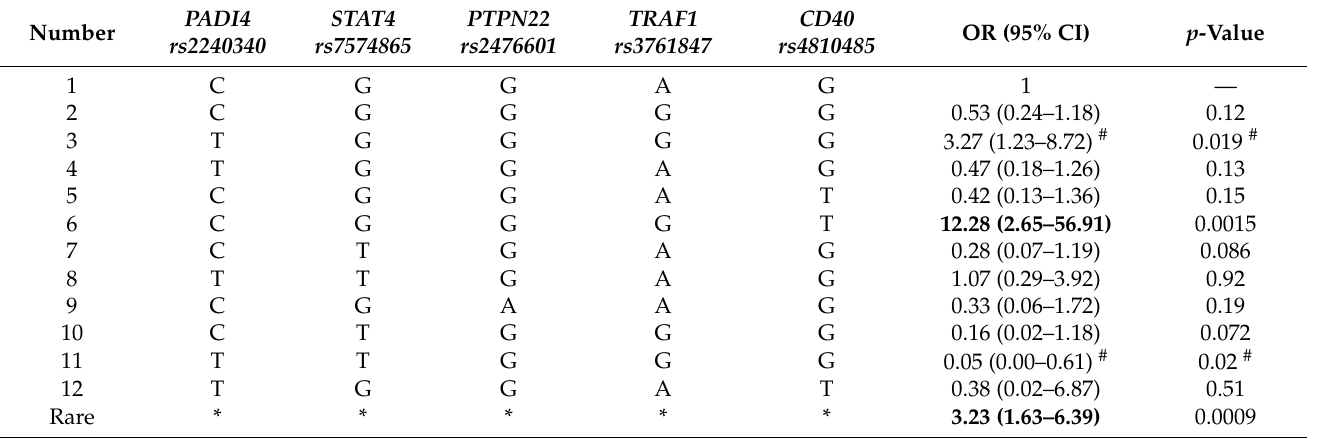
In multilocus analysis, the frequency of four haplotypes (TGGGG; CGGGT; TTGGG, and rare) was significantly higher in RA patients in comparison to controls (Table 7). The association remained significant even after Bonferroni correction ( p = 0.0017) for the two haplotypes (CGGGT and rare). Table 7. Association of RA with the frequency of haplotype of the 5 selected SNPs in PTPN22 , PADI4 , TRAF1 , STAT4, and CD40 . * described haplotypes present at frequency below 0.02. PADI4 STAT4 Number rs2240340